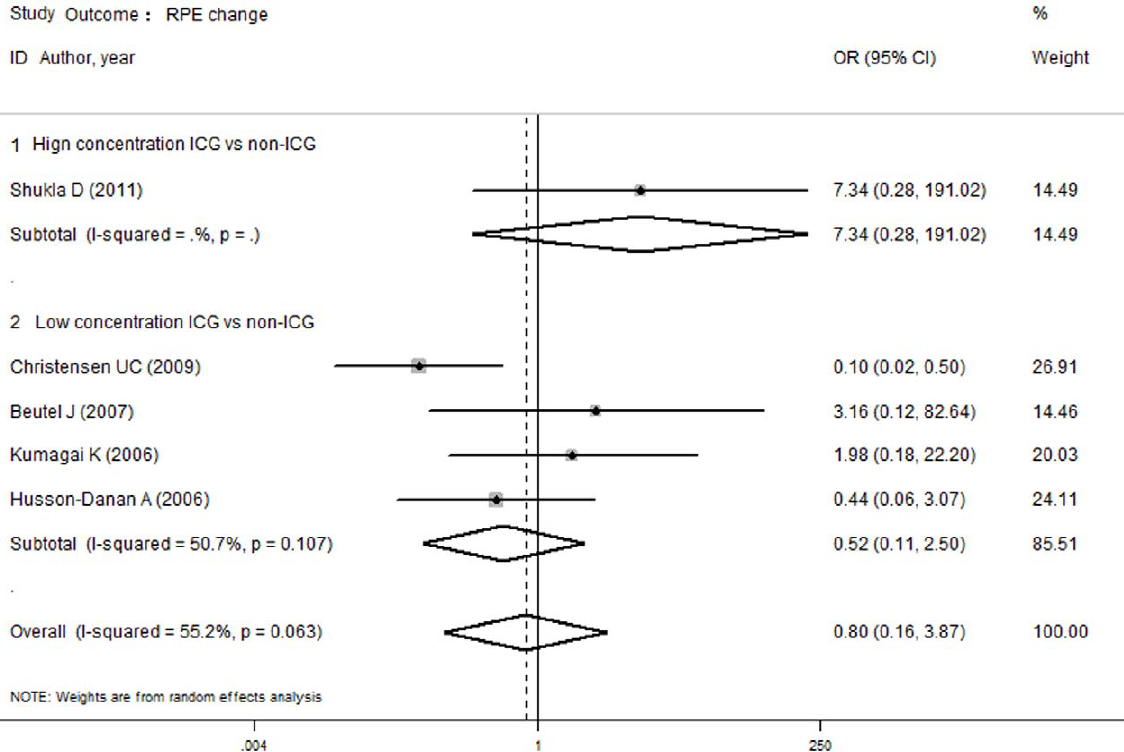
Figure 7. Subgroup analyses of outcome VA gain 20/40 in high and low concentration of ICG versus non-ICG group. There were no differences between the high or low concentration of ICG group and the non-ICG group. doi:10.1371/journal.pone.0048405.g007 PLOS ONE |